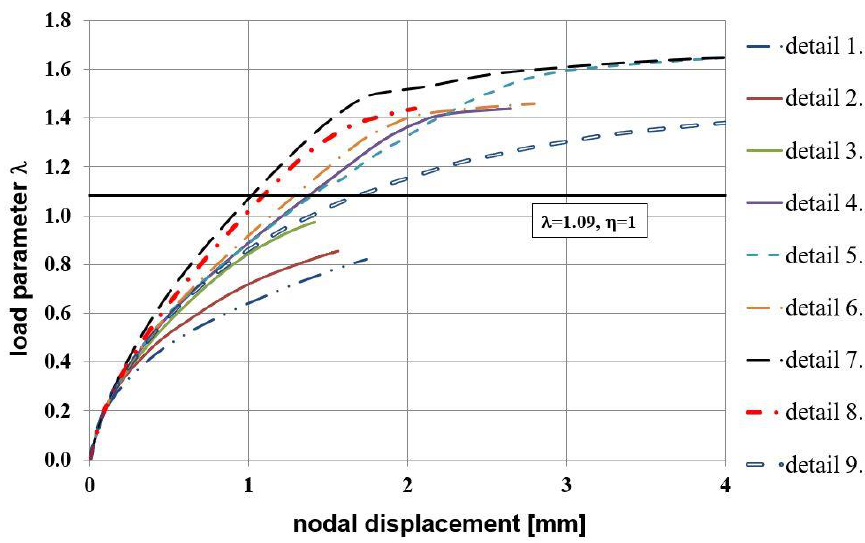
Figure 25. Nodal displacement vs. loading parameter in the plane stress state.